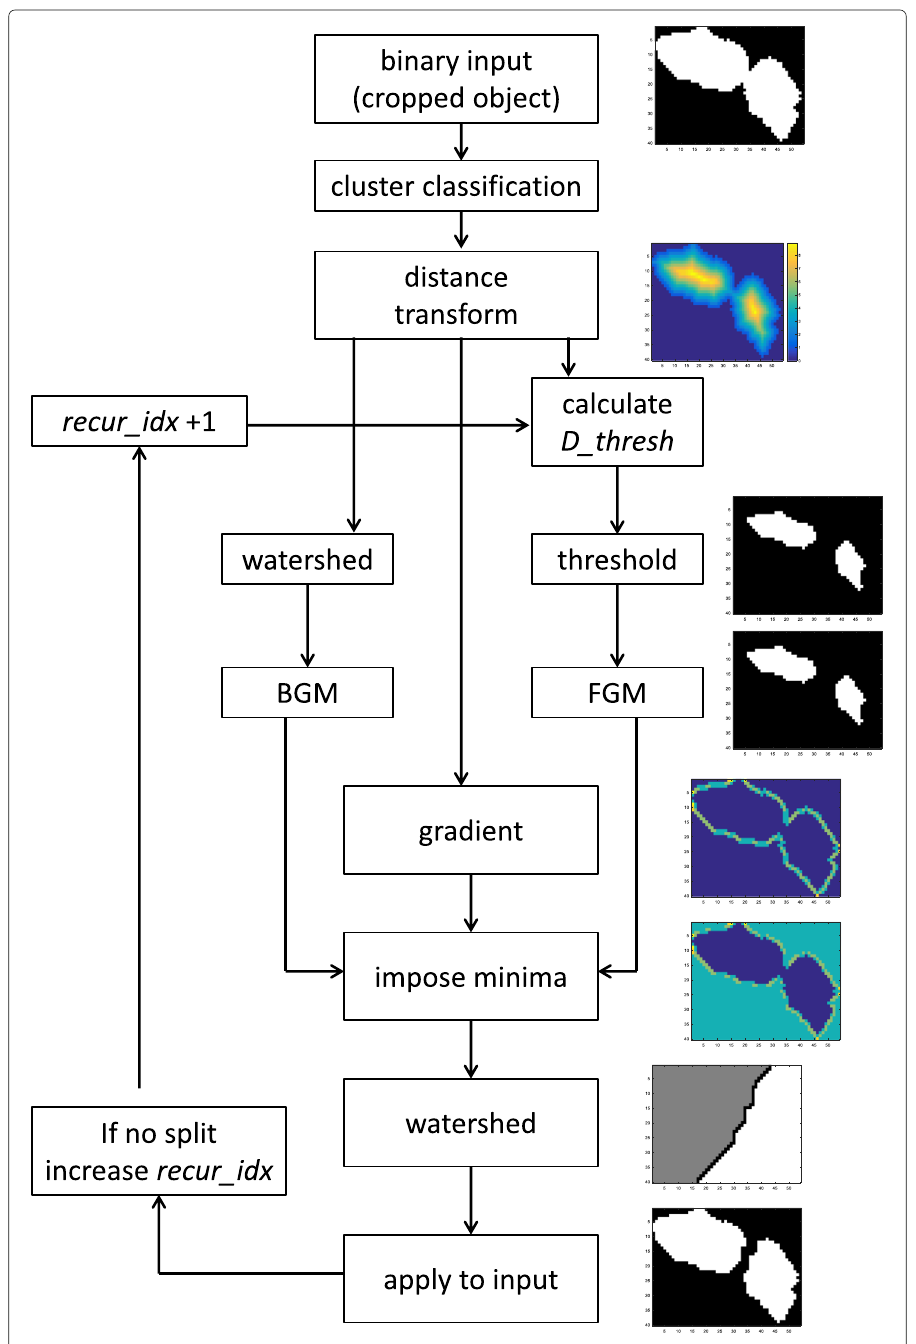
Fig. 2 The scheme of processing using our algorithm with miniature images for better understanding. Cropped binary input contains one cluster. Next, the distance transform ( D ) is calculated. Foreground markers (FGM) are established with distance transform thresholded with D _ tresh (value based on maximum value present in distance transform map, parameter T , and the recurrence index recur _ idx ). Background markers (BGM) are obtained by applying watershed algorithm to distance transform. Then, we impose minima (FGM and BGM) on the gradient magnitude of the input image. If the ridge is present in the result after applying watershed algorithm, then it is used to split the objects. If the resulting objects (tested in terms of area, eccentricity, and roundness) are still classified as clusters, then the algorithm starts again with increased recurrence